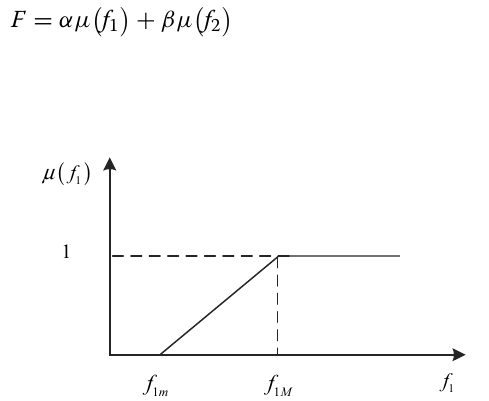
Fig. 3 Membership distribution graph of the objective